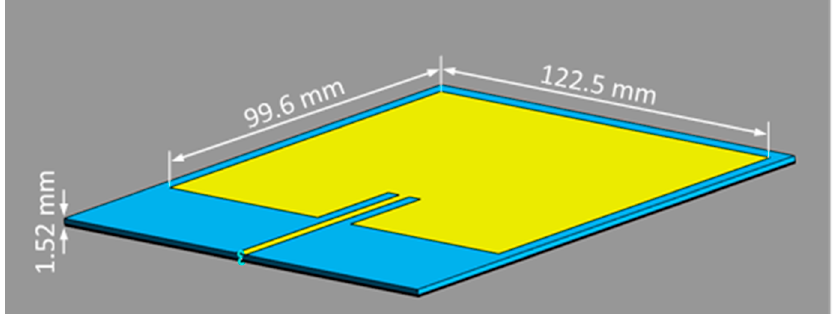
Figure 2. Numerical model of the UHF RFID reader used in investigations: microstrip patch antenna operating at 865 MHz (copper patch of 99.6 × 122.5 × 0.035 mm placed on Rogers R3003 substrate of 131.5 × 138.3 × 1.52 mm, PEC ground thickness of 0.035 mm).